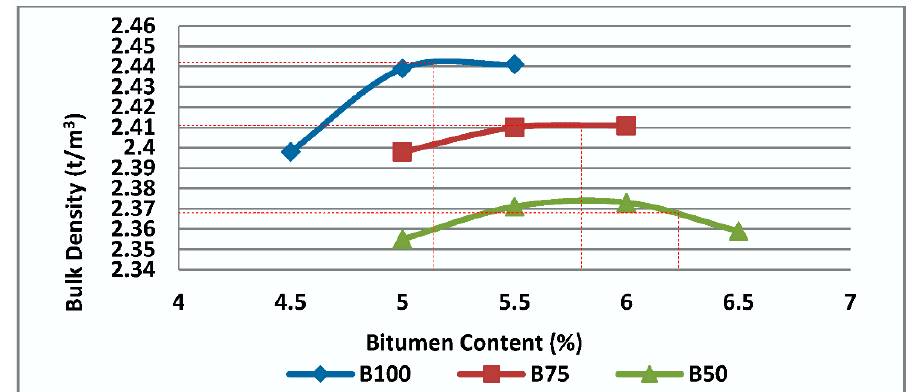
Figure 6. Effect of bitumen content and RCA content on bulk density of Mix I containing virgin aggregate and Mix II and Mix III containing RCA as coarse aggregate.